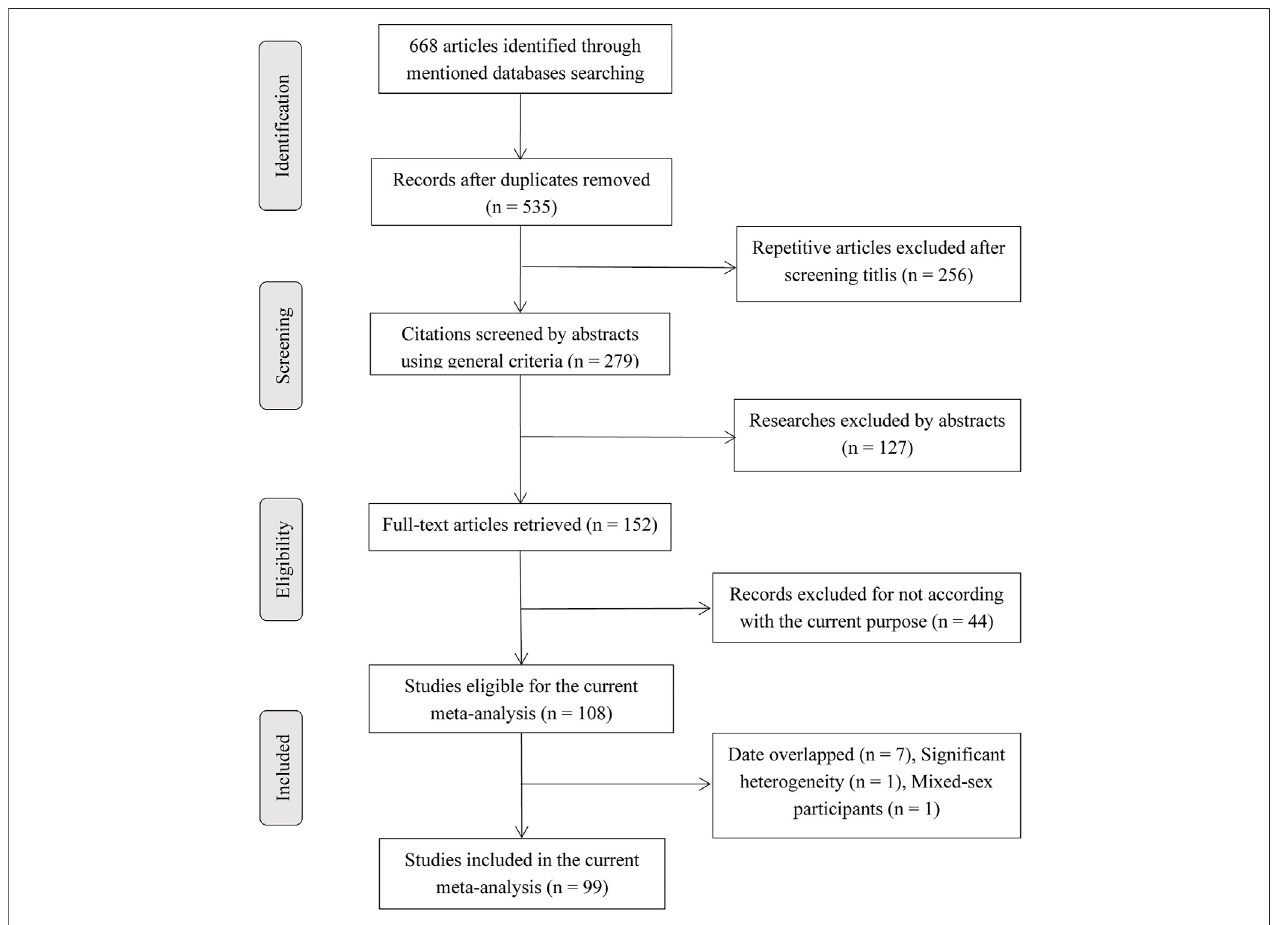
FIGURE 1 | Flow diagram for searching included